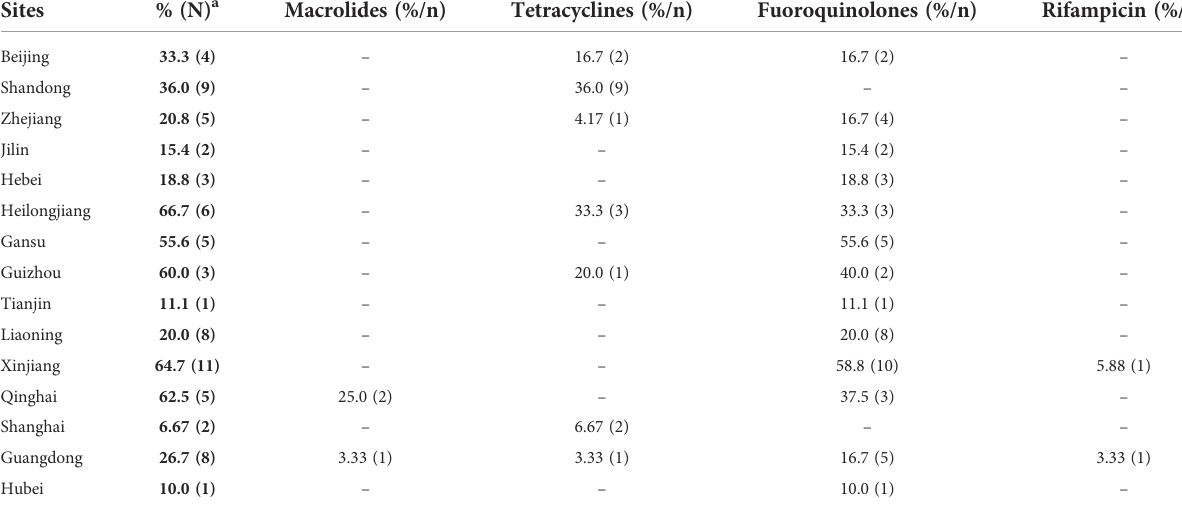
TABLE 2 Detection frequency of antibiotics in relation to province.